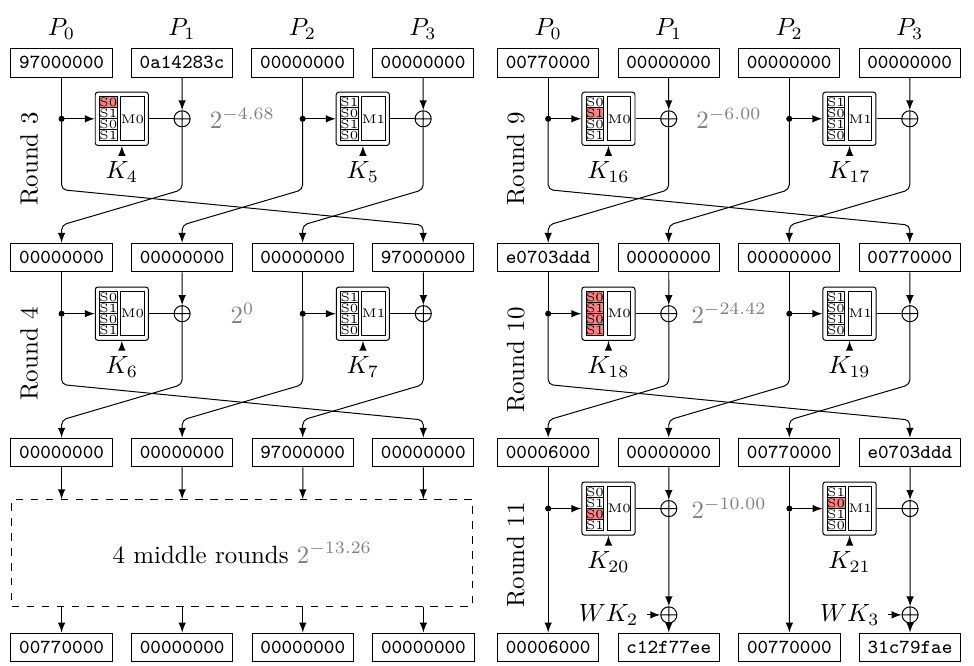
Figure 8: CLEFIA : 9-round boomerang distinguisher with probability 2 − 99 . 12 based on 2-round upper trail (left, probability 2 − 4 . 68 ), 4 middle rounds (left, 2 − 13 . 26 ), and 3-round lower trail (right, probability 2 − 38 . 25 including differential effect).